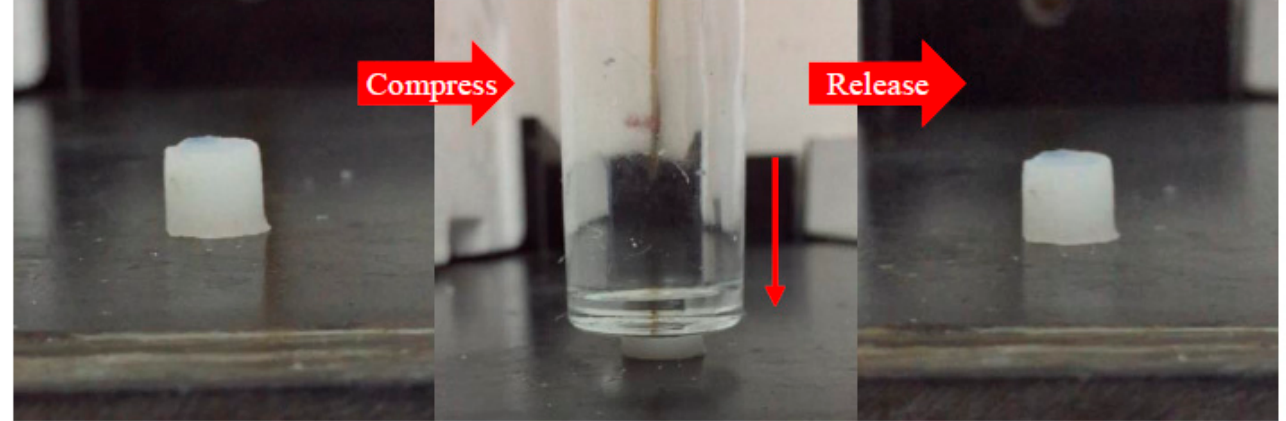
Figure 9. Observation of the elastic-like structure of the construct F8 [4% CNC: 4% Alg: 40% PEGDA] by manual compression test.